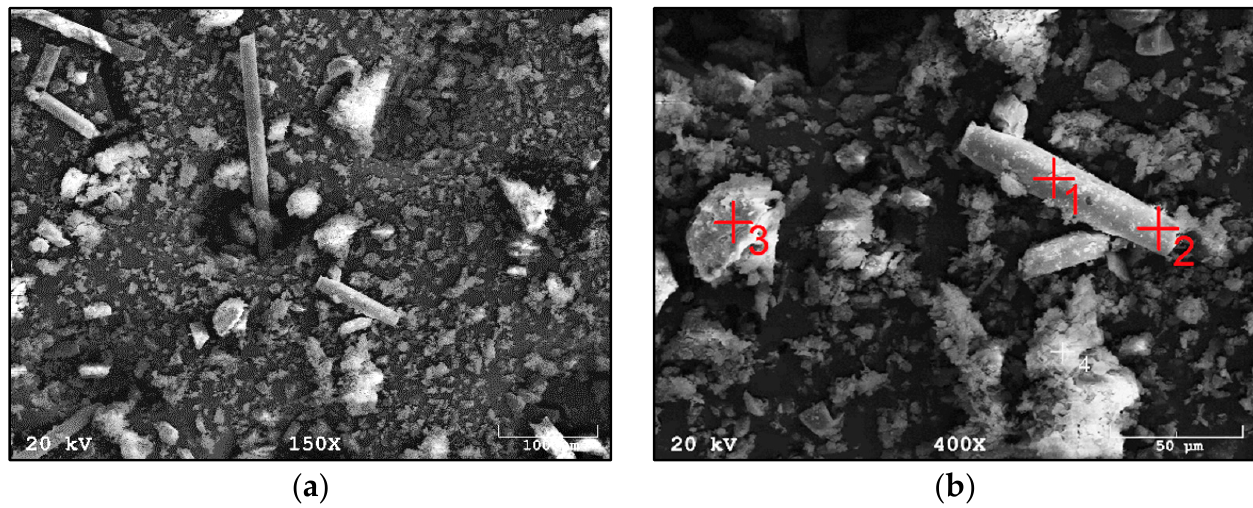
Figure 5. SEM images of fraction II from wind turbines: ( a ) in 150× magnification; ( b ) in 450× magnification.